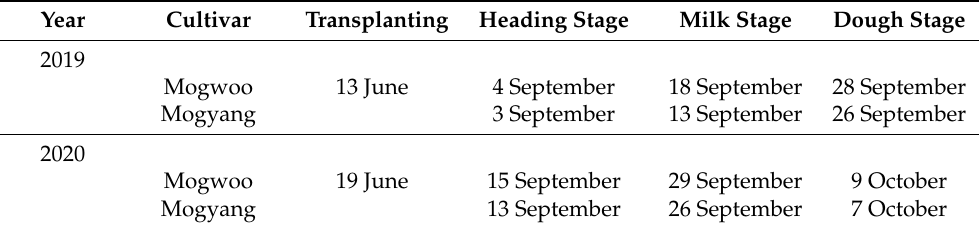
Table 2. The harvest time of ‘Mogwoo’ and ‘Mogyang’ according to the growth stage.